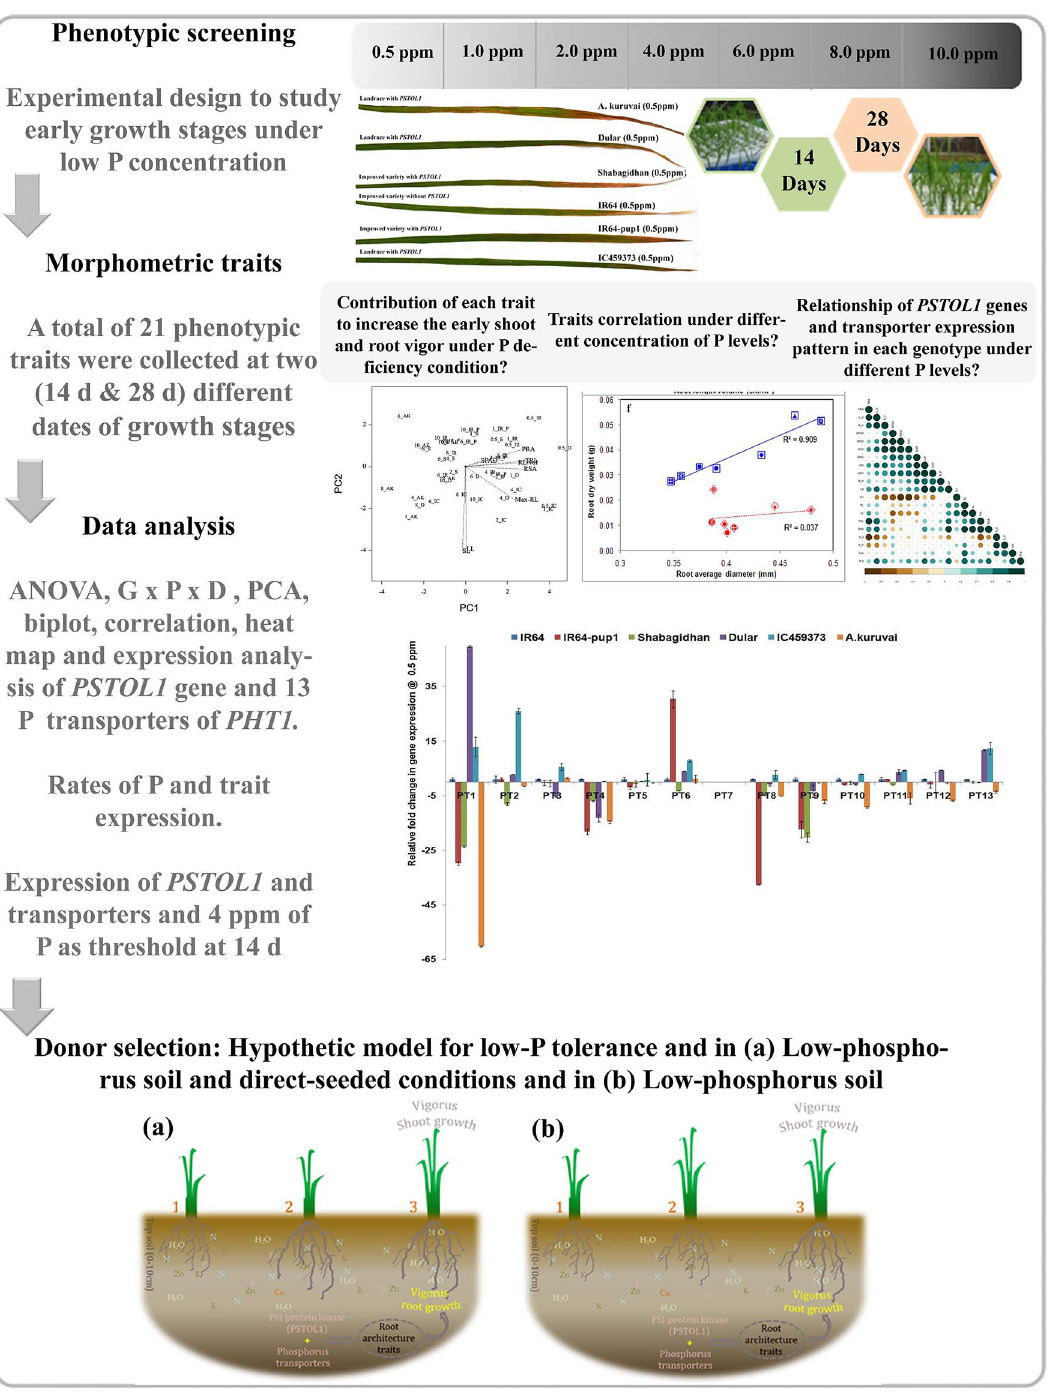
Figure 10. A schematic view of phenotypic screening under different concentrations of phosphorus and expression profiling of rice genotypes. Schematic representation of genotypes with the shoot and root vigor at 14 days (3 ‒ 4-leaf stage) after sowing in response to low P under direct-seeded ( a ) and nursery ( b ) conditions. ( a ) Low-phosphorus soil—young seedling under direct-seeded conditions: 1 = poor root and shoot vigor, 2 = root vigor but poor shoot growth, 3 = high root and shoot vigor. ( b ) Low-phosphorus soil—young seedling in the nursery: 1 = poor root and shoot vigor, 2 = poor root vigor but good shoot growth, 3 = high root and shoot